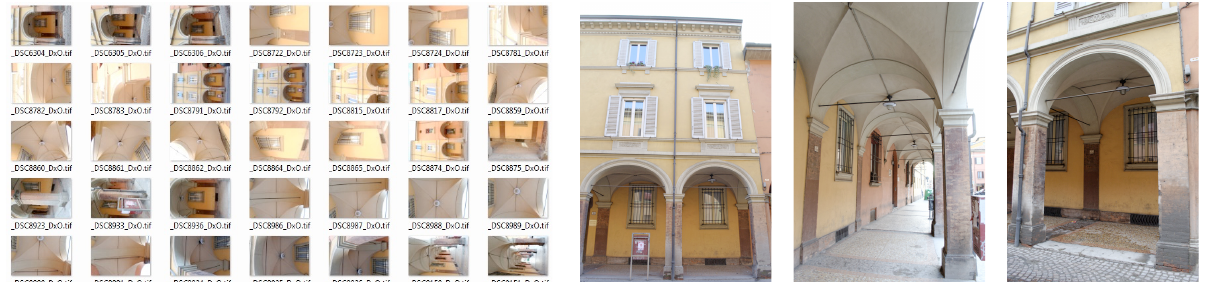
Figure 3: The Portico dataset (35 images) used for the evaluation of the developed image pre-processing pipeline. Not enhanced Enhanced a) b) VisualSFM (VSFM)